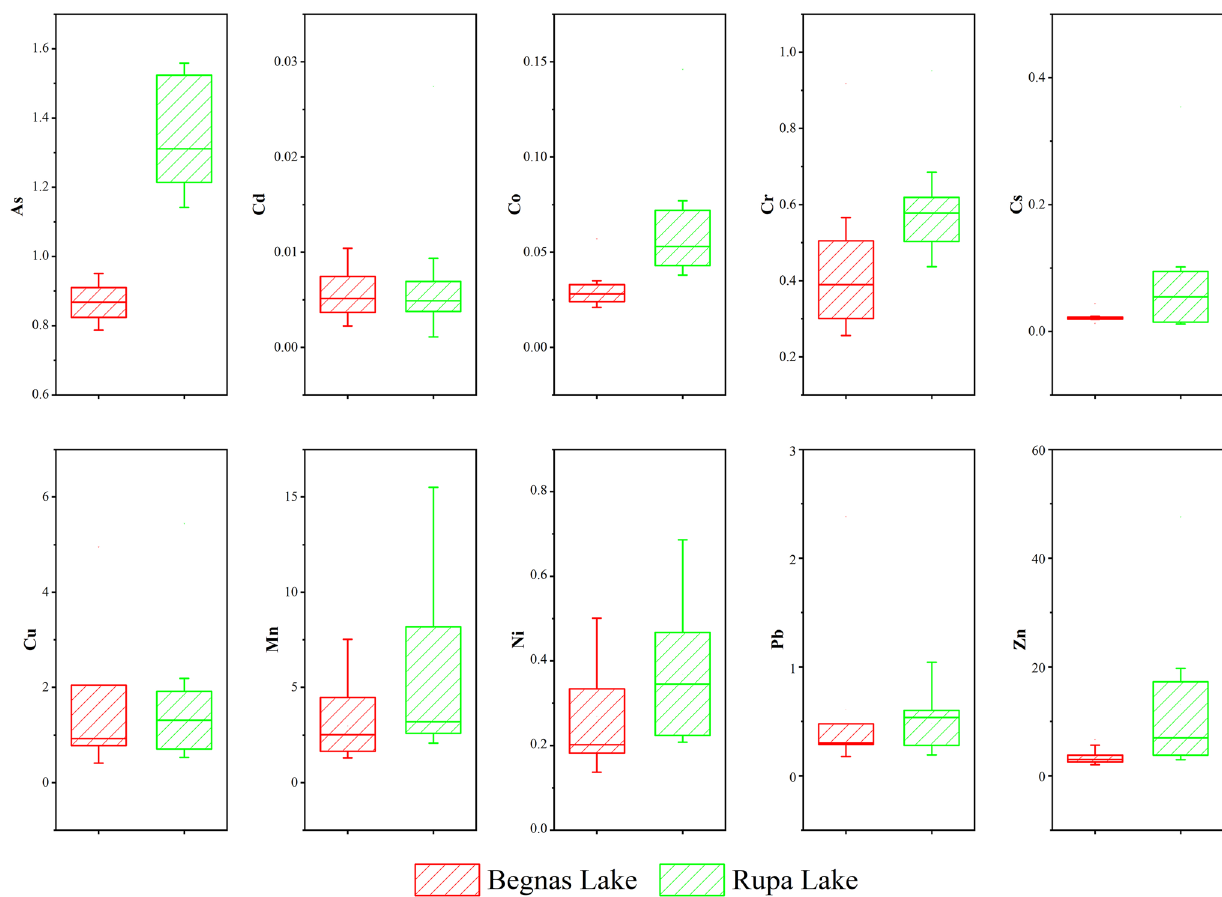
Fig. 2 Comparison of trace elements (TEs) concentration between Begnas Lake and Rupa Lake, GandakiProvince, Nepal (concentration of the TEs are expressed in